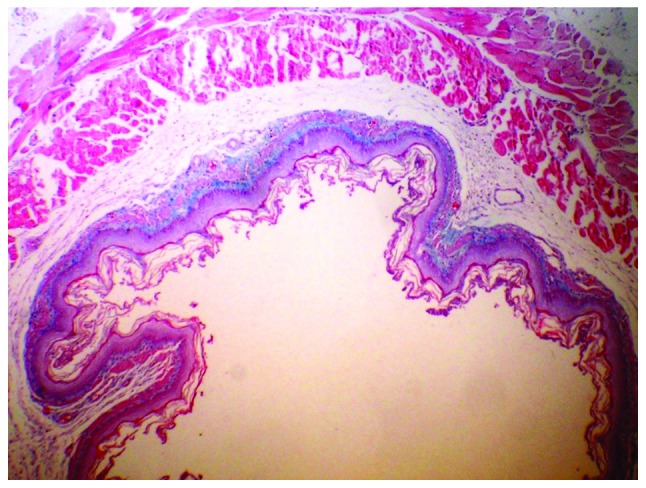
Regular mucosal, submucosal and muscular structures were observed in the palifermin-treated group. A slight increase in collagen accumulation was observed in the muscularis mucosa (magnification, ×100; staining, hematoxylin-eosin and Masson’s trichrome).